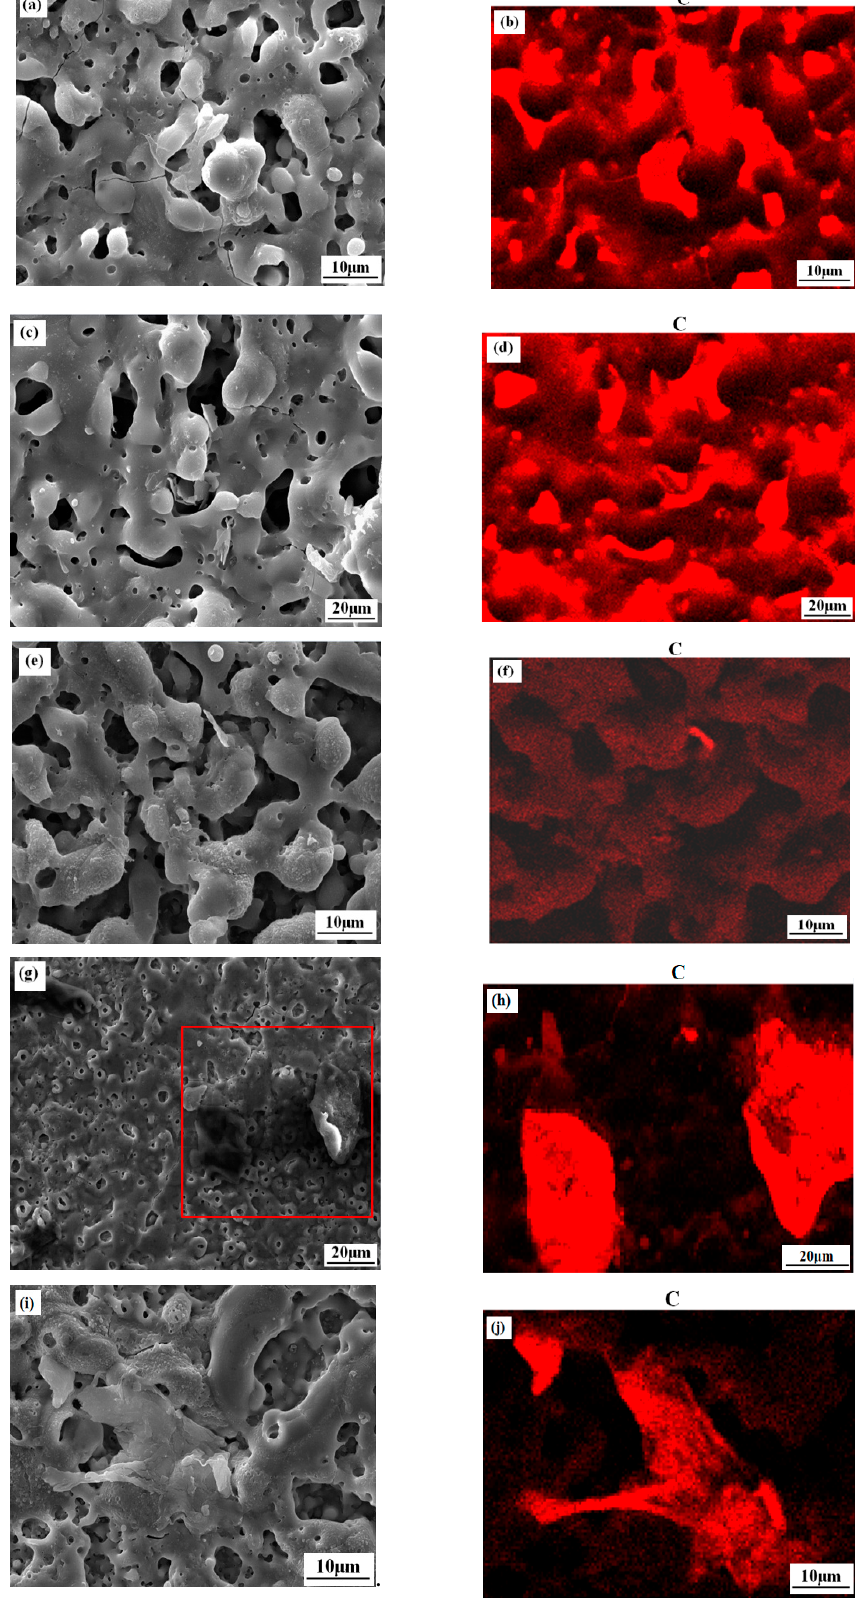
Figure 3. Surface morphologies and energy dispersive spectrometer (EDS) mapping graphs of the coatings: ( a , b ) G1, ( c , d ) G2, ( e , f ) G3, ( g , h ) G4, ( i , j ) G5; ( a , c , e , g , i ) the tested surface morphology of EDS mapping, ( b , d , f , h , j ) the EDS mapping graphs of the C element.